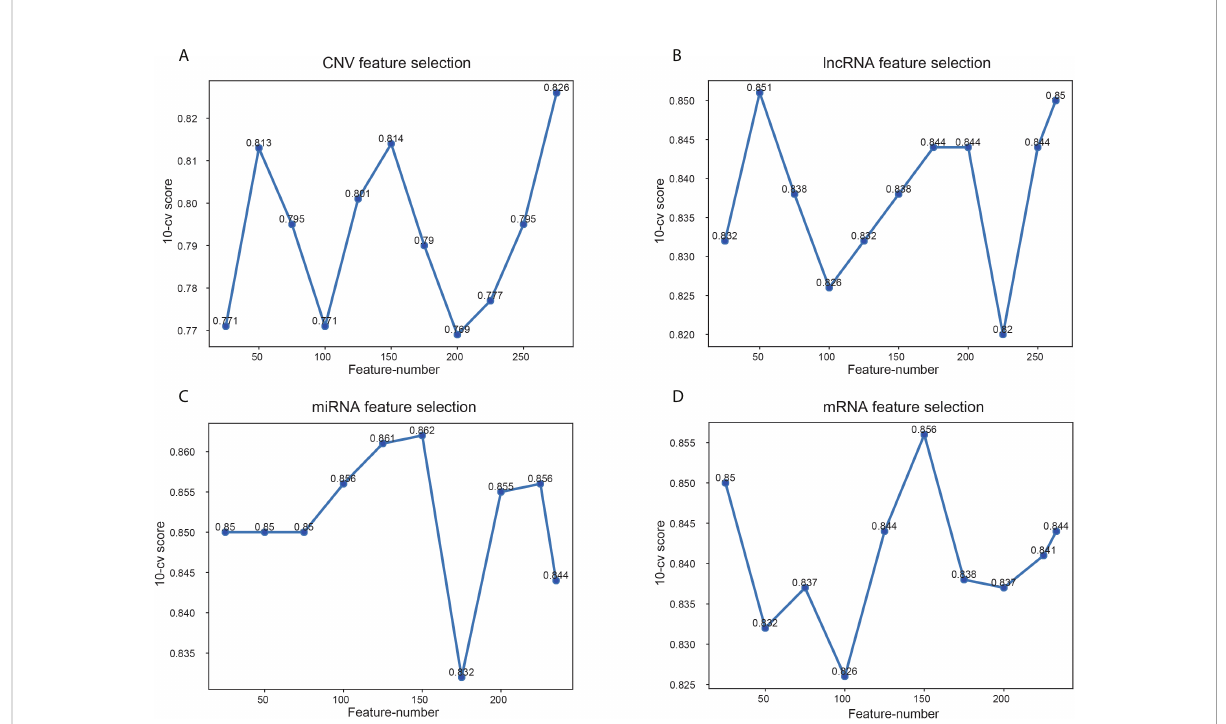
FIGURE 4 Scores of different feature number selection based on omics data. (A) Feature selection of CNV, (B) feature selection of lncRNA, (C) feature selection of miRNA, (D) feature selection of mRNA. The x-axis is feature numbers, the y-axis is the 10-CV